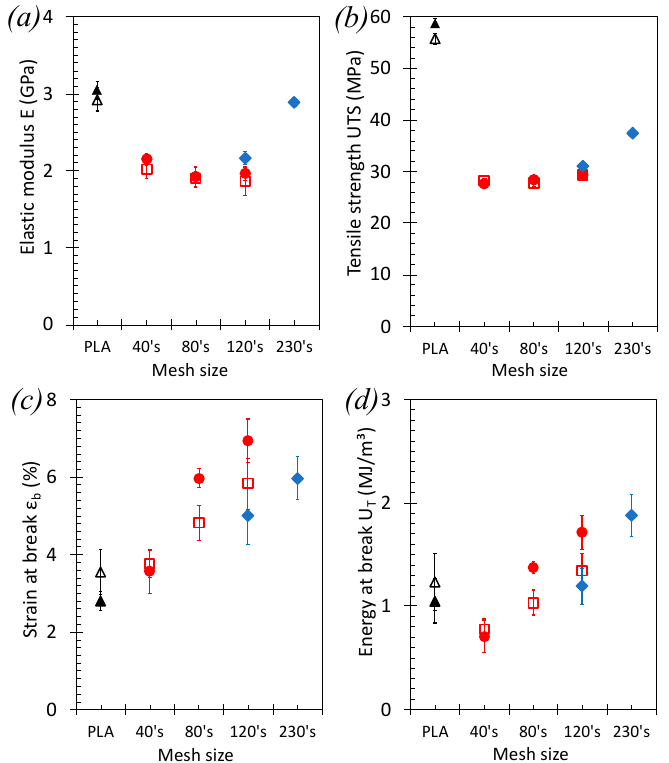
Figure 5. Effect of the GTR size on the tensile properties of PLA/GTR blends. ( a ) Elastic modulus, E T , ( b ) tensile strength UTS, ( c ) strain at break, ε b , and ( d ) energy at break, U T , measured from tensile test performed at 10 mm · min − 1 and at room temperature: neat PLA in absence of DCP (black unfilled triangle symbols), neat PLA in presence of 1.5 wt% DCP (black filled triangle symbols), PLA/GTR a 15% in absence of DCP (red square symbols), PLA/GTR a 15% in presence of 1.5 wt% of DCP (red ring symbols) and PLA/GTR c 15% in presence of 1.5 wt% of DCP (blue diamond symbols). All blends were processed at 170 °C in presence of Irganox (0.2 wt% of total amount of material).